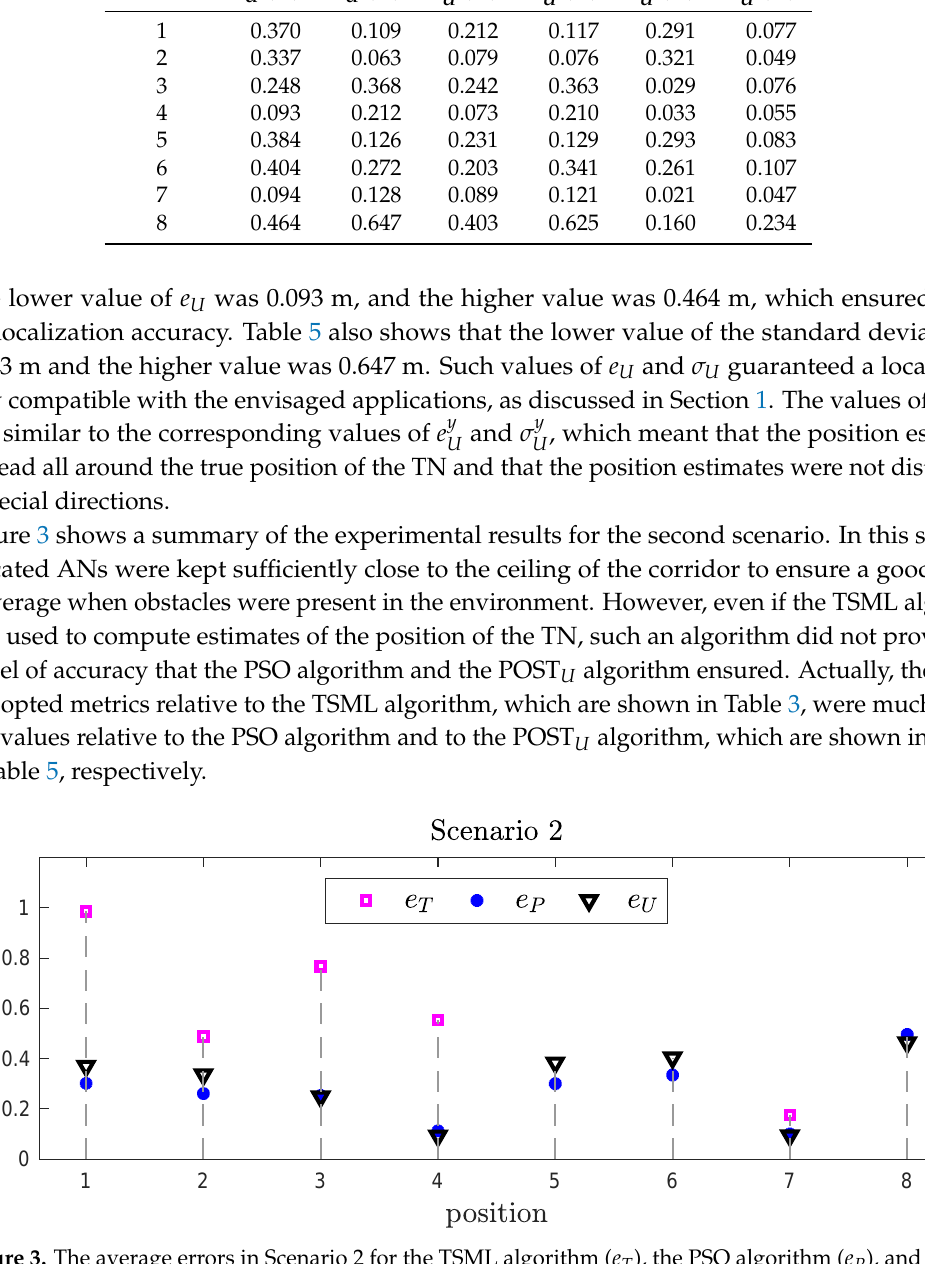
Figure 3. The average errors in Scenario 2 for the TSML algorithm ( e T ), the PSO algorithm ( e P ), and the POST U algorithm ( e U ) shown in